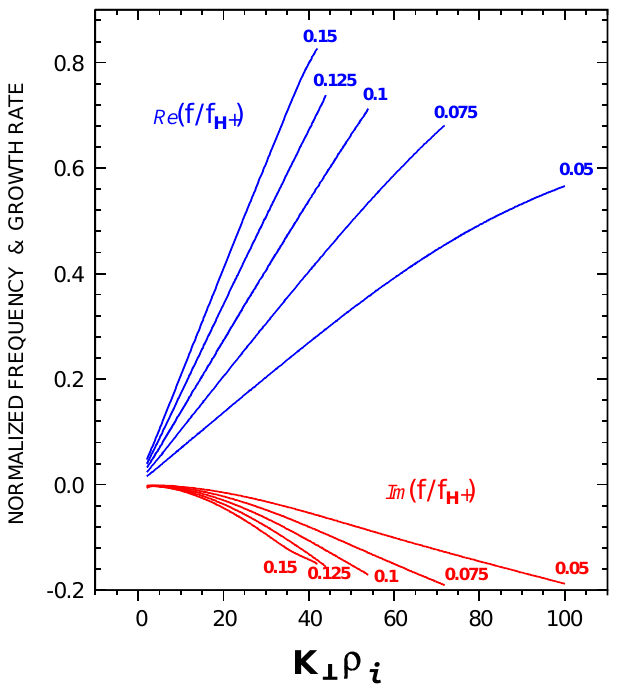
Fig. 7. Real (blue) and imaginary (red) part of the frequency nor- malized to the proton gyrofrequency, versus k ⊥ ρ i , for k // ρ i be- tween 0.05 and 0.015. For k ⊥ ρ i ∼ 1 − 10 (ion scale) the damp- ing rate is small, but it becomes large for k ⊥ ρ i ∼ 20–100 (elec- tron scale). Parameters are N i = 4cm − 3 , B 0 = 10nT, T e = 35eV, T i = 400eV; therefore β = 6.